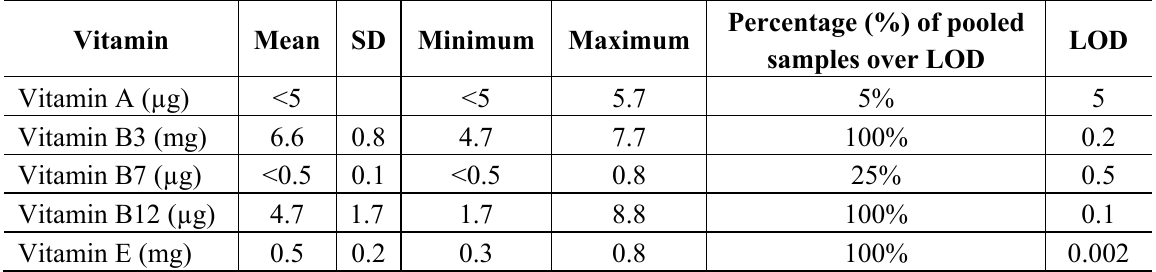
Table 1. The overall grand mean concentrations of the studied vitamins per 100 g raw meat ( n = 20 pooled samples composed of 100 individual meat samples. Vitamin Mean SD Minimum Maximum